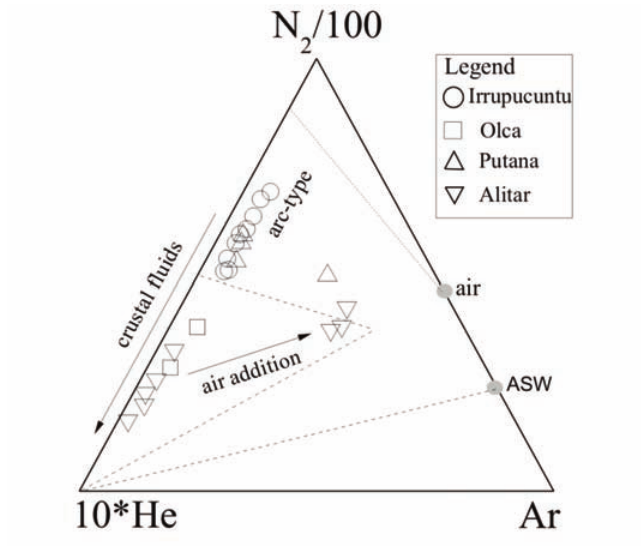
Figure 9. Ar-N -He ternary diagram. ASW, air-saturated water. Symbols as 2 in legend to Figure